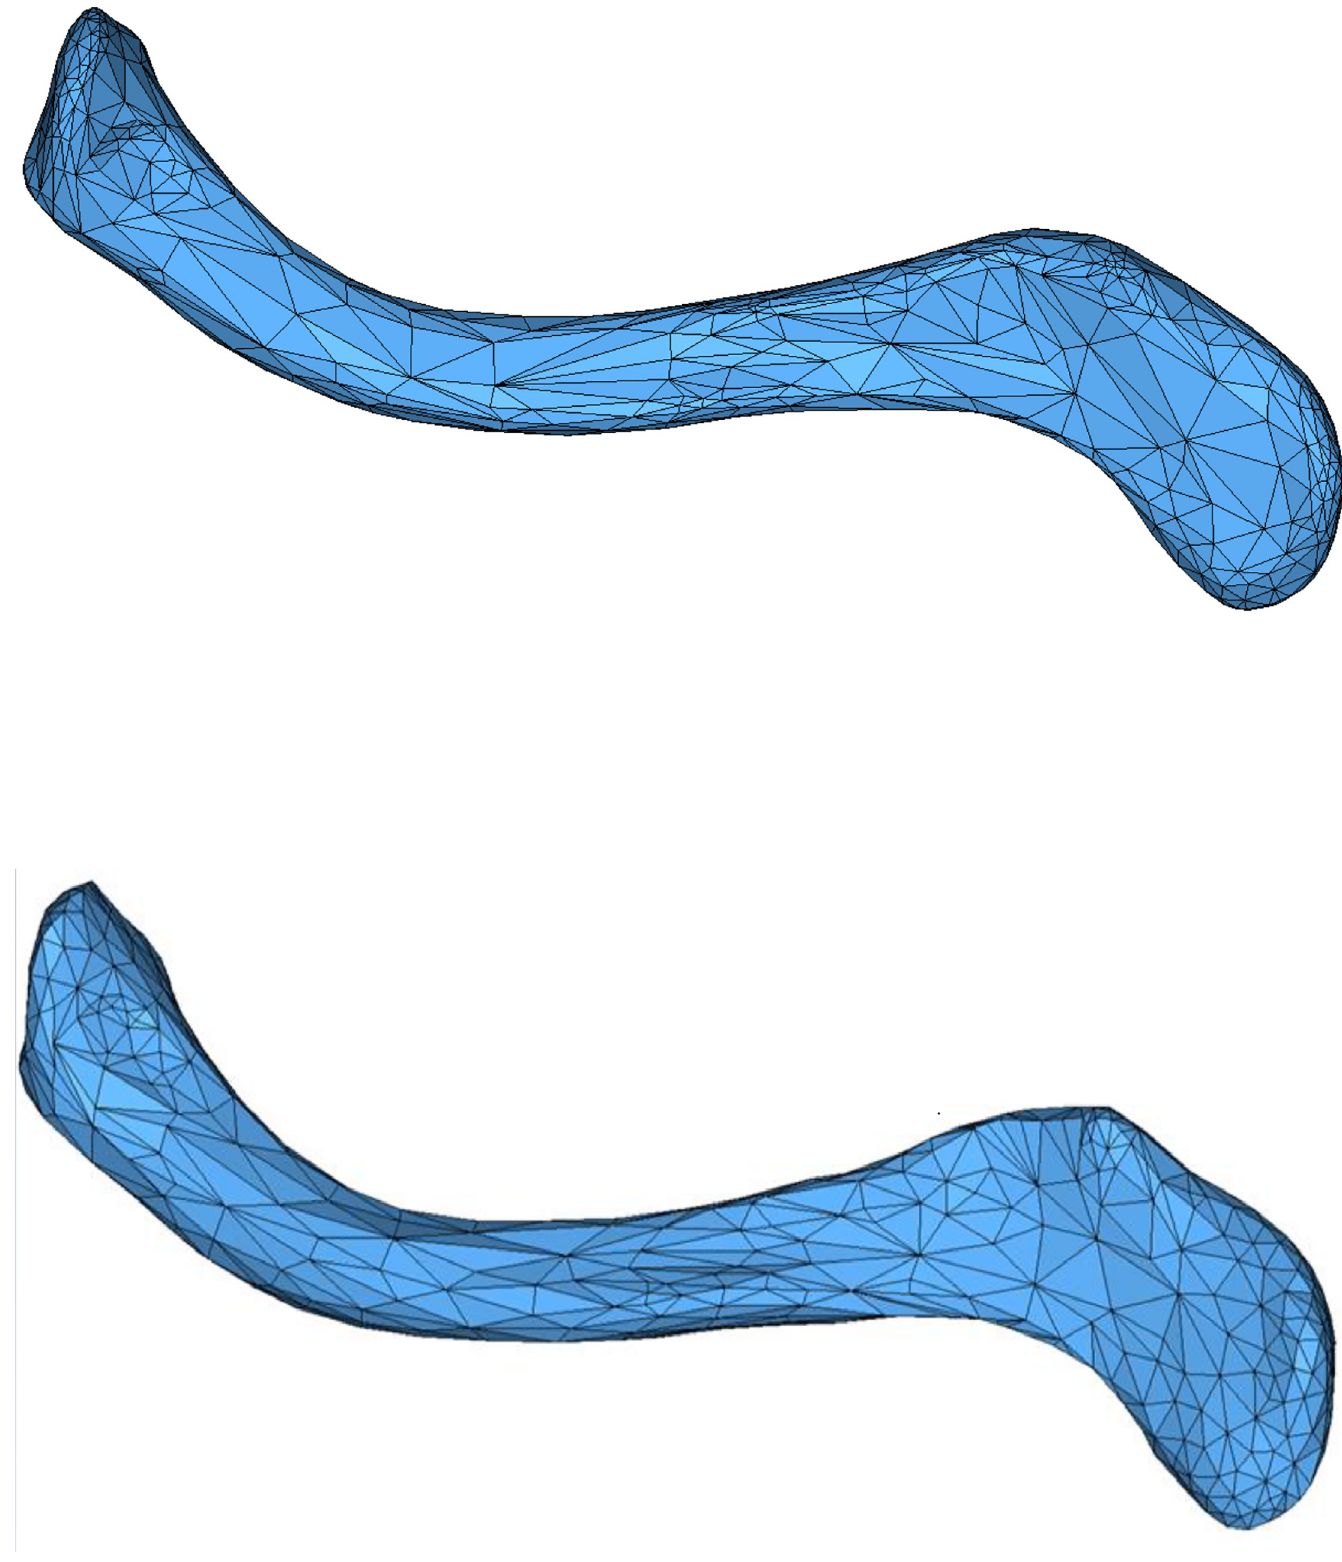
Fig 14. Example 4 before(a) and after(b) EAS smoothing.